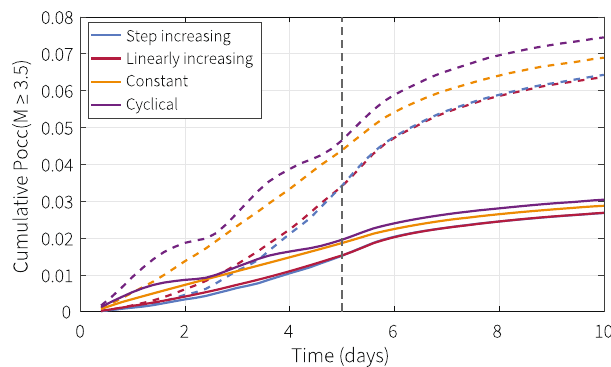
Fig. 6 Cumulative probability of occurrence of an M3.5 + event for the different injection strategies. The solid lines correspond to the homogeneous cases, and the dashed lines to the cases with